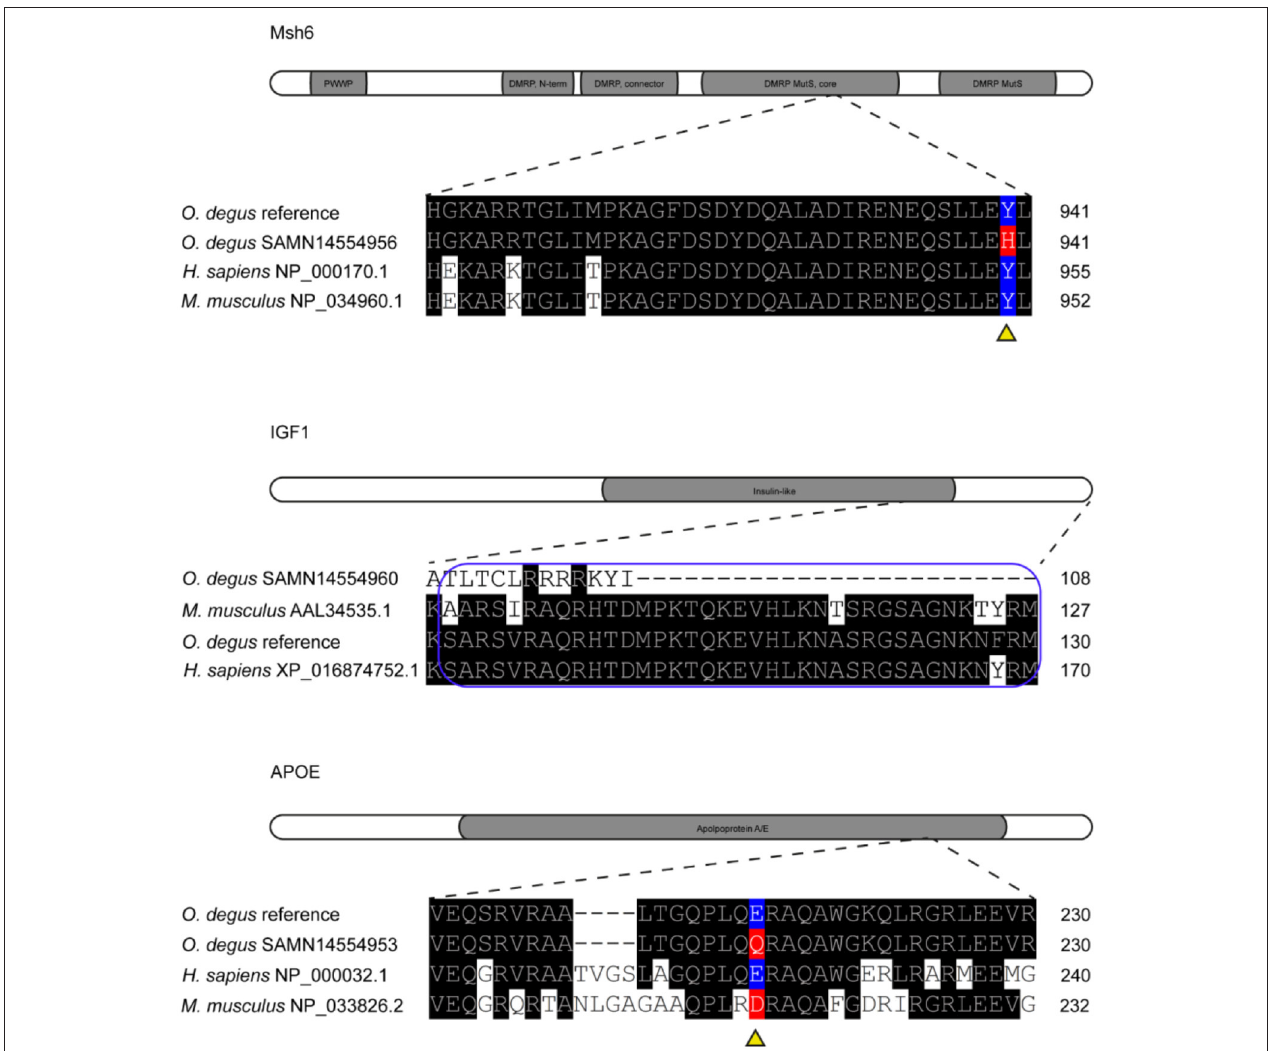
FIGURE 3 | Missense variants in Msh6, IGF1 and APOE genes of degu. Representation of Msh6, IGF1 and APOE genes with missense mutations aligned to degu reference genome annotated gene and human amino acid sequence. Amino acid changes are highlighted in red. Reference amino acids are highlighted in blue. Gray shading shows functional domains of each gene. DMRP correspond to DNA mismatch protein MutS domain. The E-peptide of IGF1 is outlined in blue.